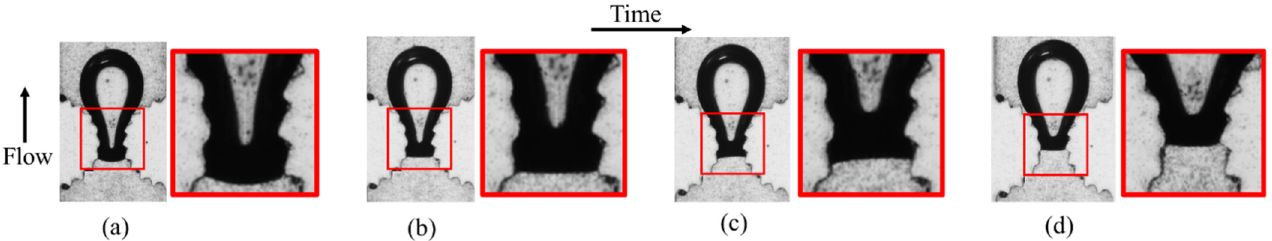
Figure 8. Phase pinning of a bubble. ( 𝑅 (cid:3029) ~1.95 mm) at different stages passing through a rough pore space having ( a ) convex, ( b ) flat, ( c ) concave, and ( d ) flat trailing edge